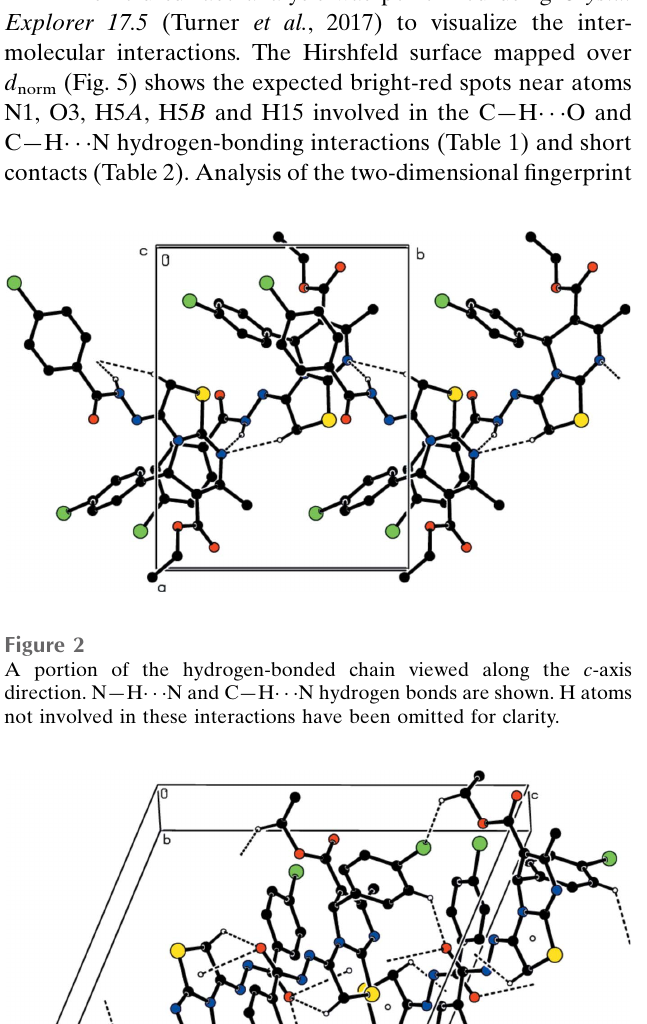
Fig. 3; Cg 1 is the centroid of the thiazole ring, symmetry code: